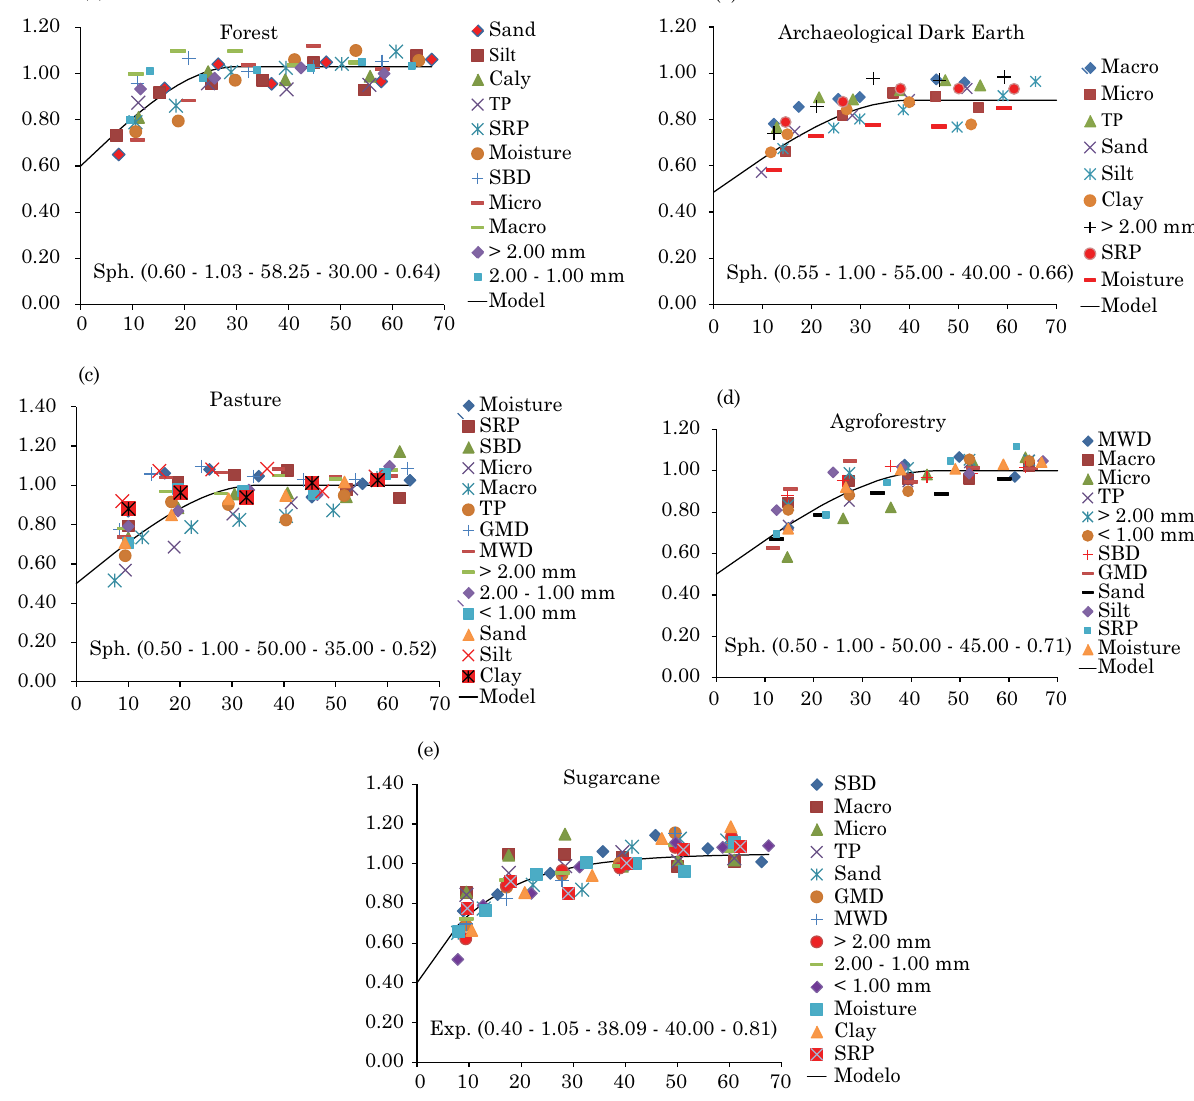
Figure 2. Scaled semivariograms for physical properties of environments in the municipalities of Humaitá and Manicoré in the south of Amazonas. Exp: exponential; Sph: spherical; [model (nugget effect - sill - DSD - R 2 - range - residue)]. DSD: Degree of Spatial Dependence; R 2 : coefficient of